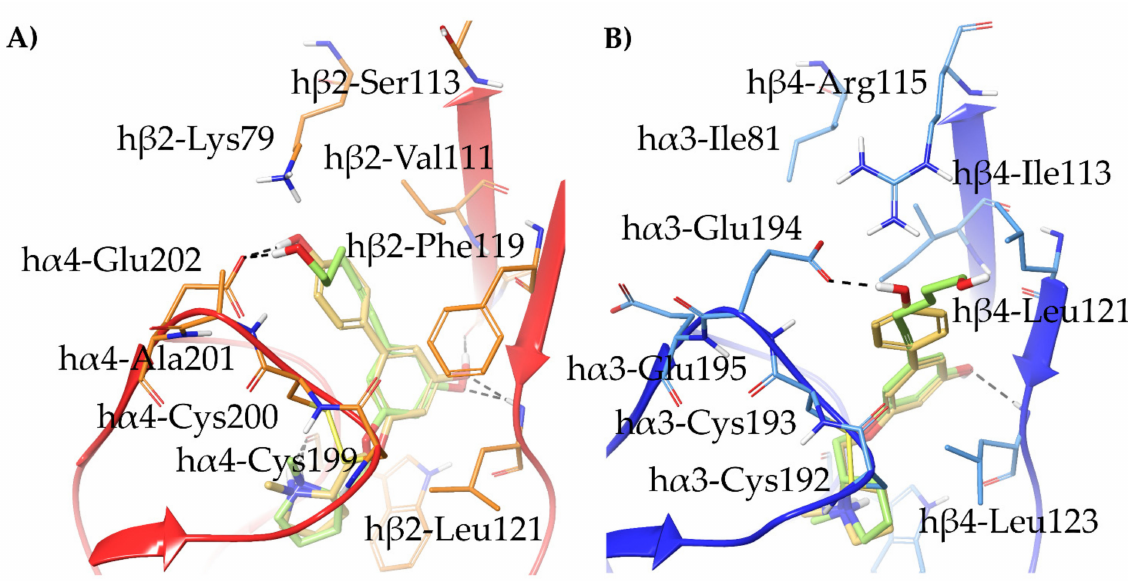
Figure 8. Proposed binding modes of the selective α 4 β 2 ligand ( S )- 15 (yellow-green) and of the unselective ( S )- 16 (yellow) at the ( A ) h α 4 β 2 nAChR and at the ( B ) h α 3 β 4 nAChR. Receptor backbones are represented with red (h α 4 β 2) and blue (h α 3 β 4) cartoons, while h α 4 β 2 and h α 3 β 4 residues are shown in orange and light blue, respectively. Hydrogen bonds are depicted with black dashed